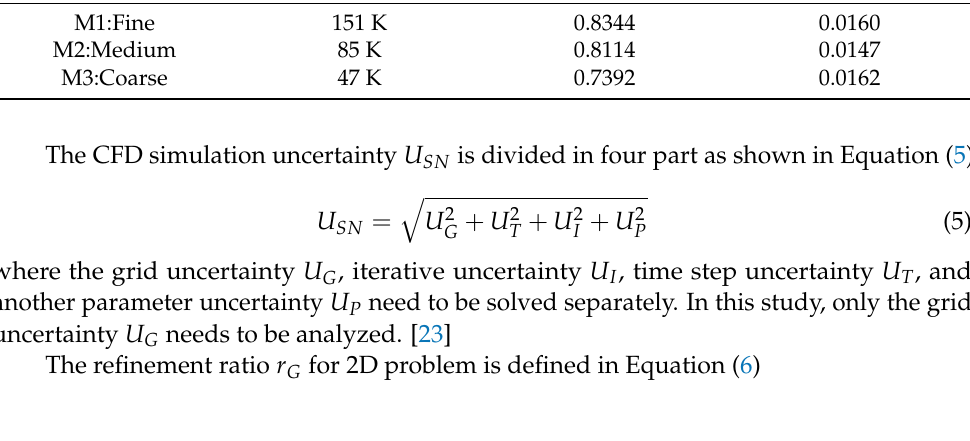
Table 2. Grid numbers and lift, drag coefficients of each grid Mesh. Mesh Total Elements Lift